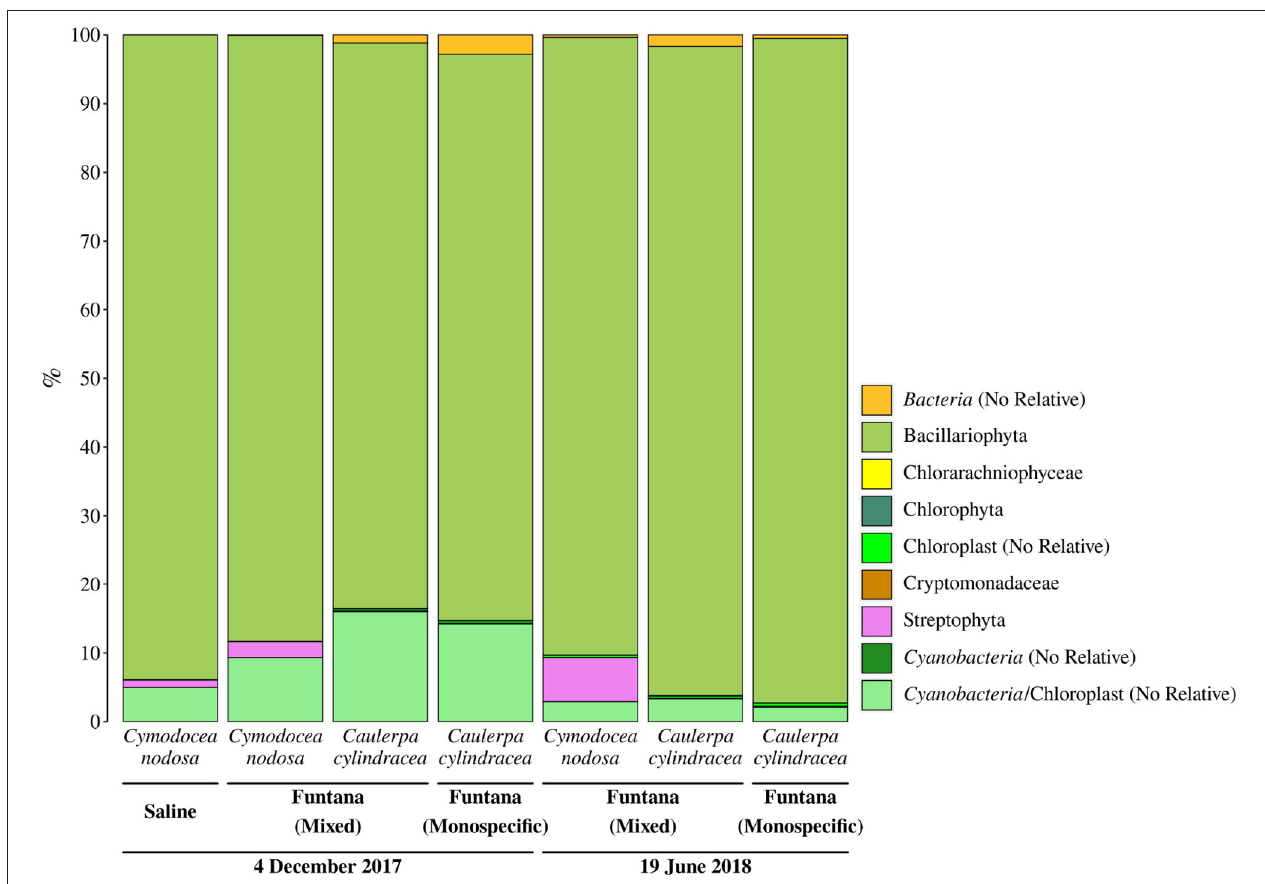
FIGURE 4 | Taxonomic classification and relative contribution of chloroplast sequences from surfaces of two marine macrophytes ( C. nodosa and C. cylindracea ) sampled in the Bay of Saline and the Bay of Funtana (mixed and monospecific settlements) and in two contrasting seasons (December 4, 2017 and June 19, 2018).